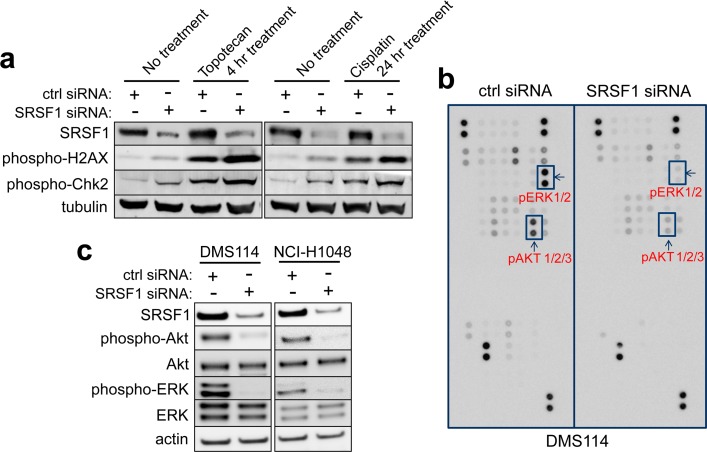
Mechanism of action for SRSF1 in SCLC.a) SRSF1 prevents DNA-damage. DMS114 cells were transfected with control or SRSF1 siRNA and then treated with topotecan or Cisplatin for the indicated times. SRSF1, phosphor-H2AX and phosphor-Chk2 were probed with their corresponding antibodies. b) c) SRSF1 mediates the activation of AKT and ERK pathways. DMS114 cells transfected with ctrl or SRSF1 siRNAs were lysed and applied to the phospho-kinase array as detailed in Materials and Methods. The dot blot result was further confirmed by western blot in both DMS114 and NCI-H1048 cells.